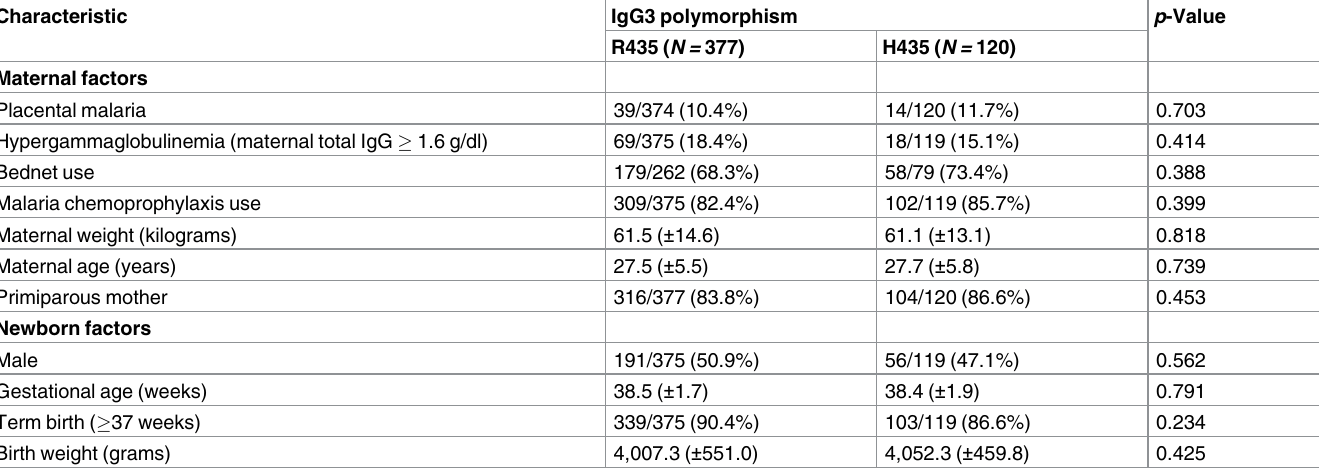
Table 1. Population characteristics according to the IgG3 polymorphism at position